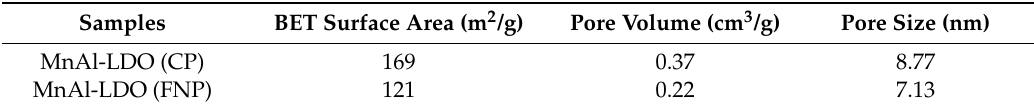
Table 1. The BET surface area, pore volume, and pore size of MnAl-LDO (CP) and MnAl-LDO (FNP)